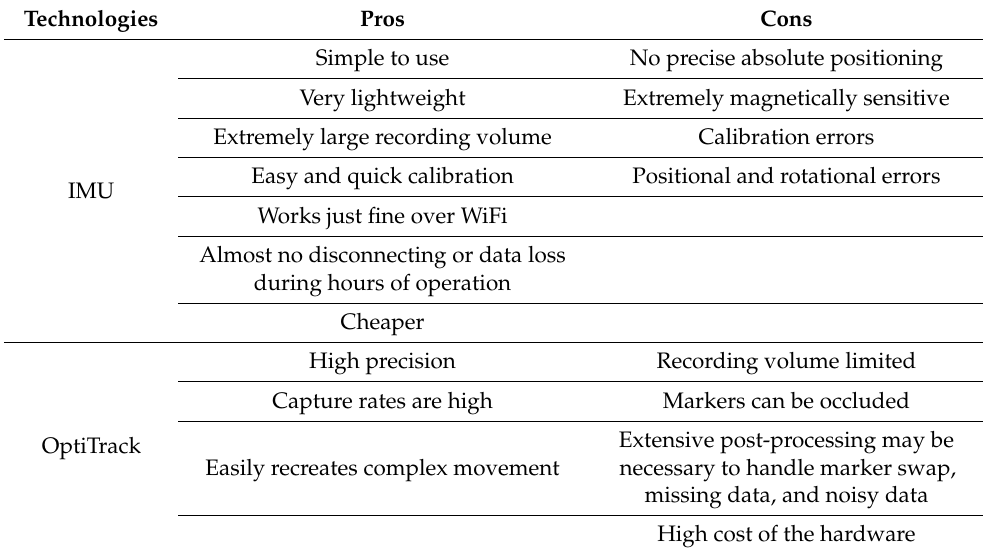
Table 4. Comparison of considered tracking